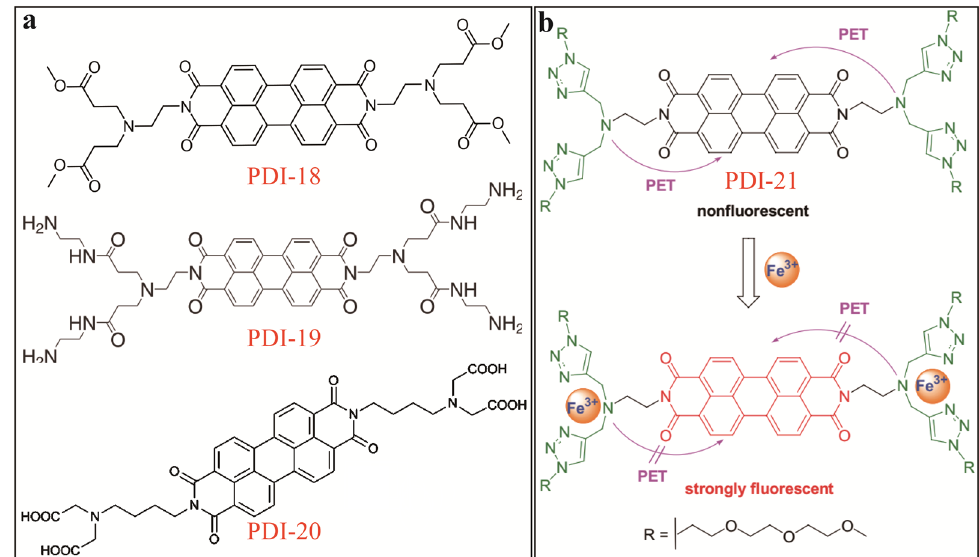
Figure 7. ( a ) Molecular structures of PDI-18 and PDI-19, and PDI-20. ( b ) Schematic illustration of Fe 3+ -binding induced fluorescence turn-on mechanism of PDI-21. Reproduced with permission from [27], copyright 2014 Wiley.